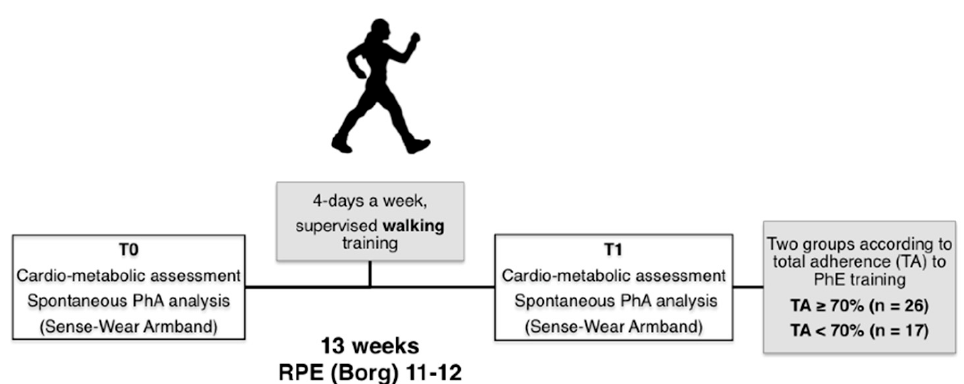
Figure 1. Flow-chart of study protocol. Abbreviations: PhA, physical activity; RPE, rated perceived exertion; TA, total adherence; T0, pre-training; T1, post-training.